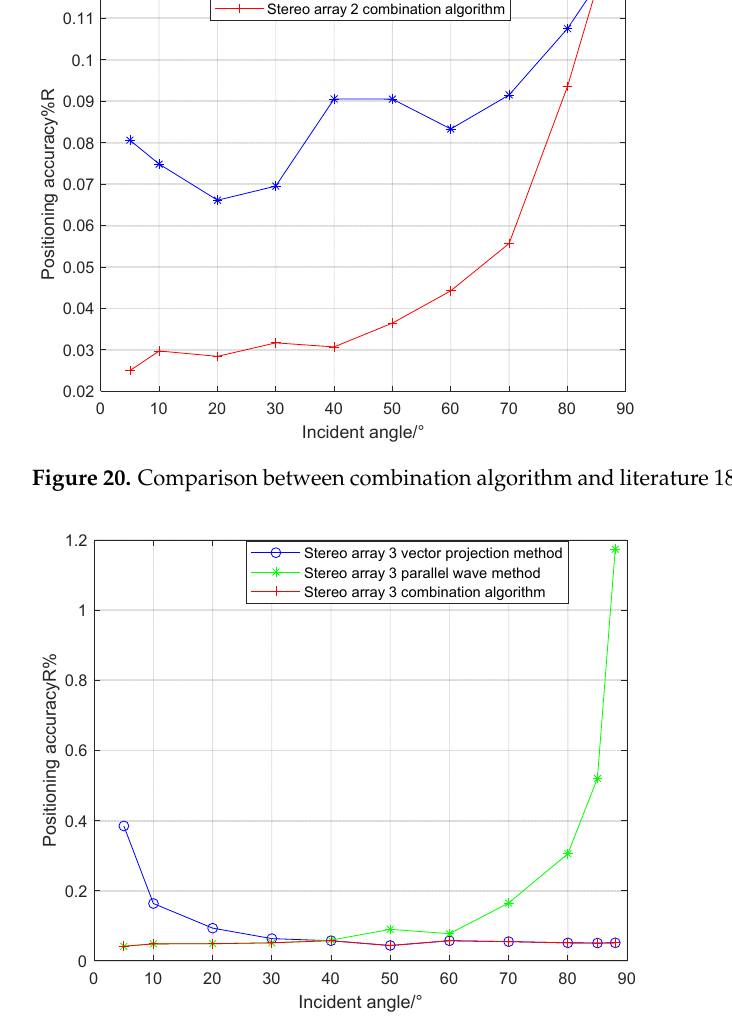
Figure 21. Comparison between combination algorithm and precombination algorithm for stereo array 3.